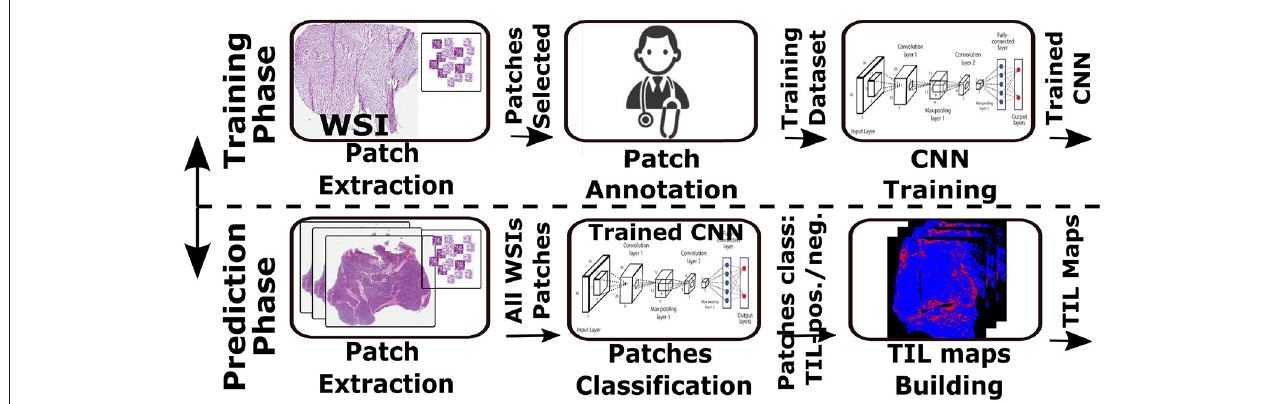
FIGURE 1 | Use-case TIL analysis workflow. CNN is trained to identify TIL rich tissue based on patches annotated by expert pathologist (top). The CNN model is then used to classify input WSI in a patch basis. The result is a TIL map presenting TIL rich regions in the input